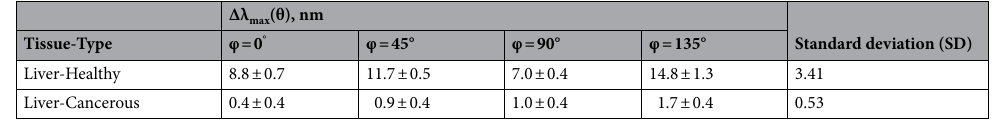
Table 1. Total spectral shift (Δλ max (θ)) due to reabsorption of the LIF in liver tissue for different orientations.